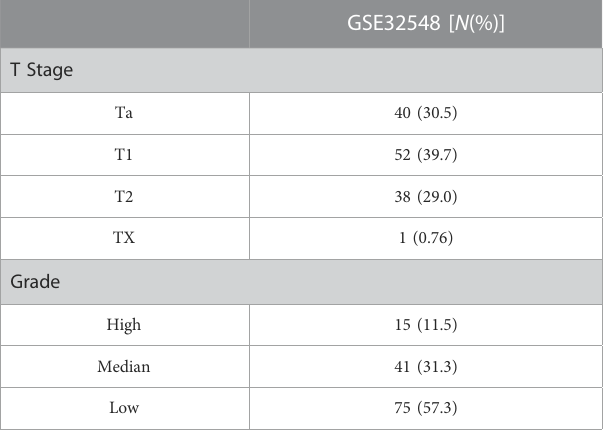
TABLE 1 Baseline data sheet of GSE3548 ( N = 131